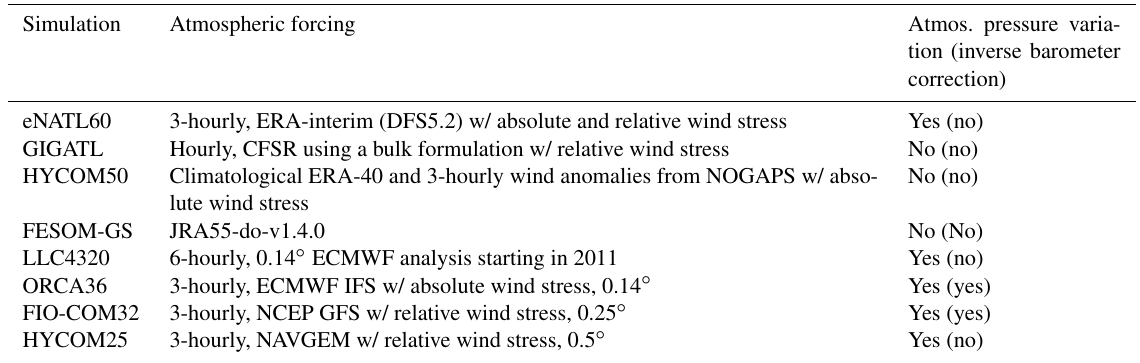
Table B6. The atmospheric forcing and the inclusion of atmospheric pressure variation at the